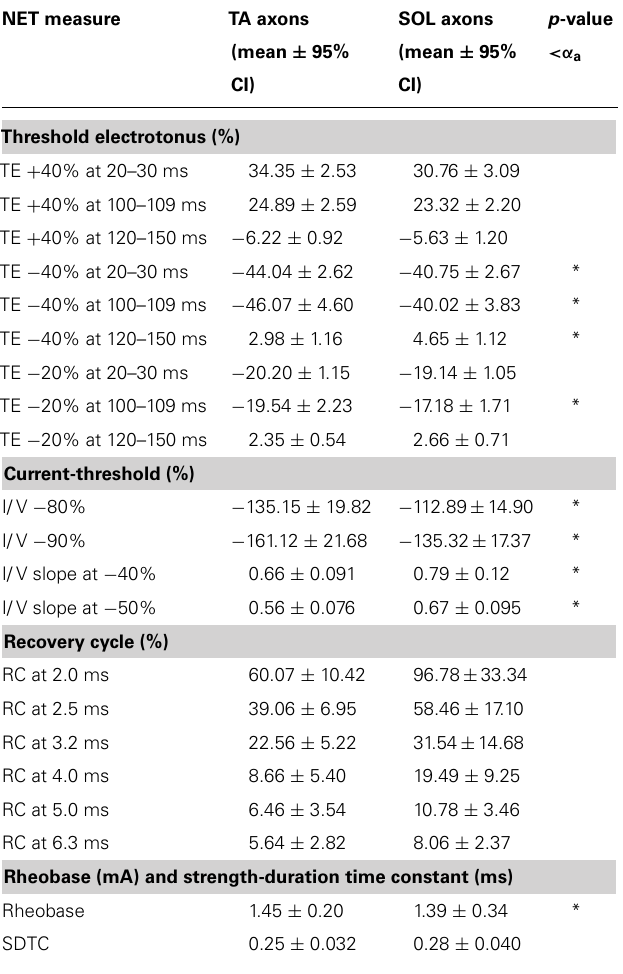
Table 1 | Mean values and 95% confidence intervals for the dependent variables generated by nerve excitability testing (NET) of fast TA versus slow SOL motor axons.